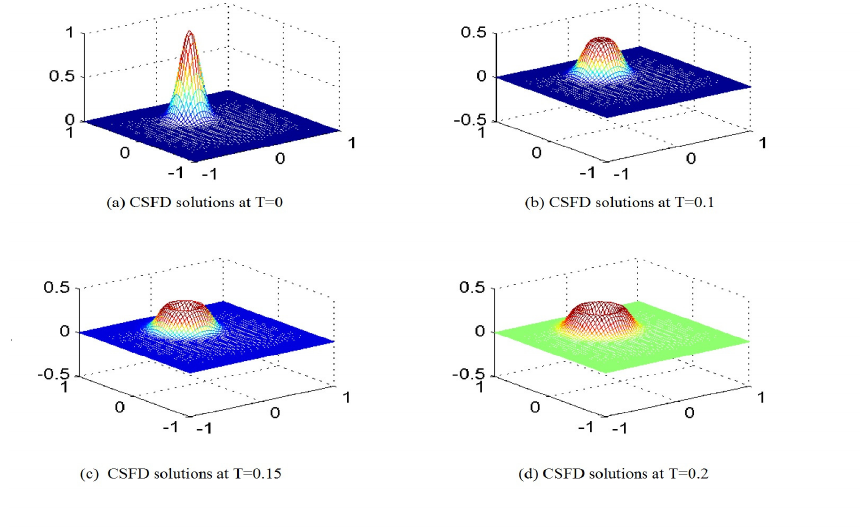
Figure 2. The CSFD solutions at T = 0 , 0 . 1 , 0 . 15 , 0 .